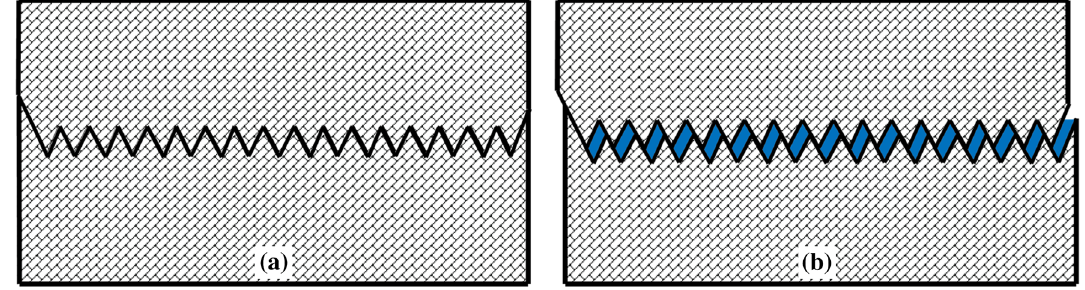
Fig. 2 Natural fractures slip and self-supporting after opened. Subfig- ure ( a ) is a closed natural fracture; Subfigure ( b ) is an opened natural fracture, which slides under the displacement caused by the opening